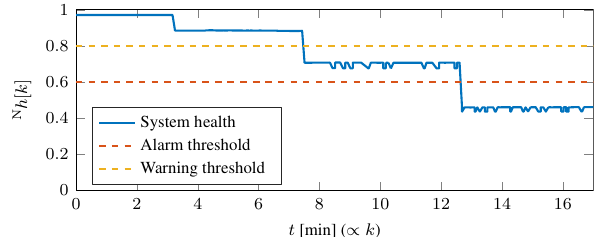
Figure 9. The system health N h [ k ] of the monitored system during a leakage over time. It is the aggregated result of the fusion process on system level (cf. Eq. 4) and represents the state of the store. The depicted warning and alarm thresholds were manually set. They are used for the generation of alarms for